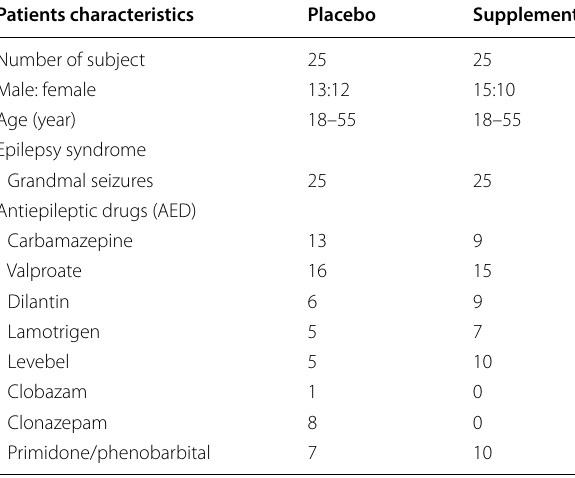
Table 1 The characteristics of patients in each study group Patients